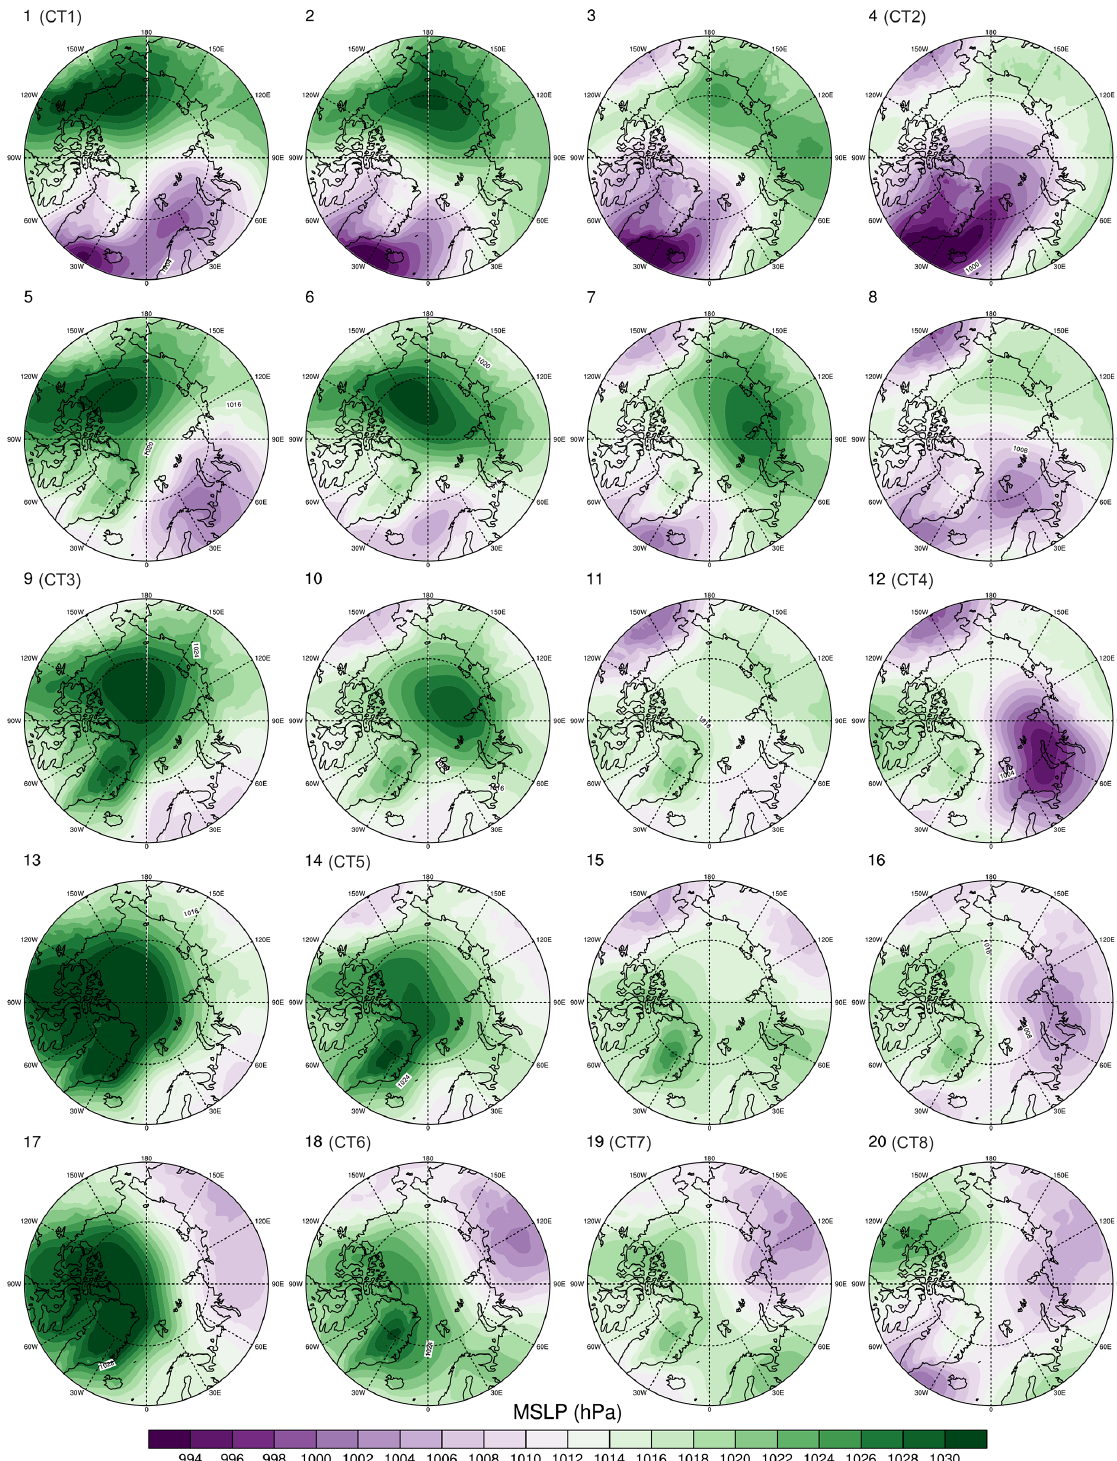
Figure A1. Mean sea level pressure (MSLP) averaged over the cases belonging to each of the 20 circulation types. The chosen eight circulation types are shown in the